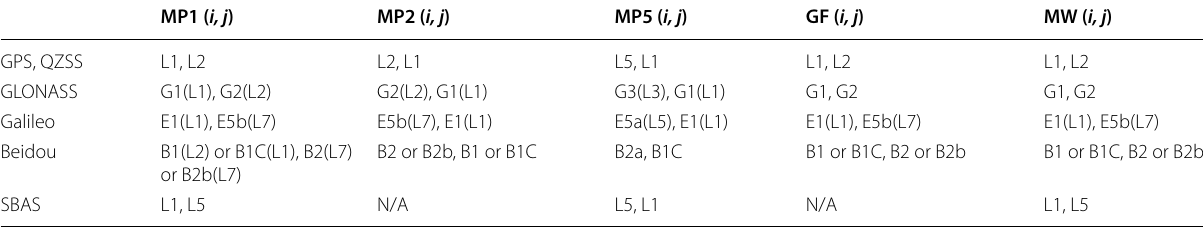
Table 3 Pair of the frequency bands used for each linear combination